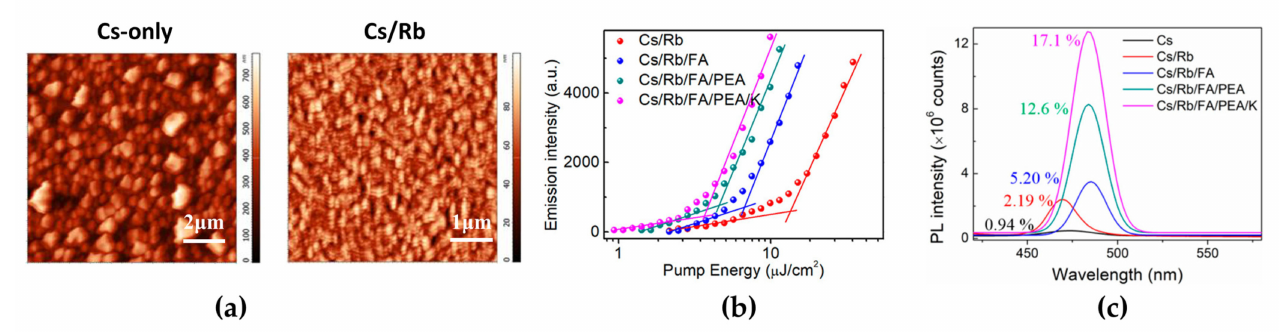
Figure 3. ( a ) Atomic force microscopy images of the CsPb(Cl/Br) 3 (RMS = 113 nm) and (Cs/Rb)Pb(Cl/Br) 3 (RMS = 13.3 nm) films. ( b ) Integrated PL emission intensity of different per- ovskite films as a function of laser pumping energy. ( c ) PL spectra and PL quantum yields (PLQYs) of APb(Cl/Br) 3 (A = multiple cations of Cs, Rb, formamidinium (FA), phenylethylammonium (PEA), and K) films. Reprinted with permission from [48], Copyright 2020 American Chemical